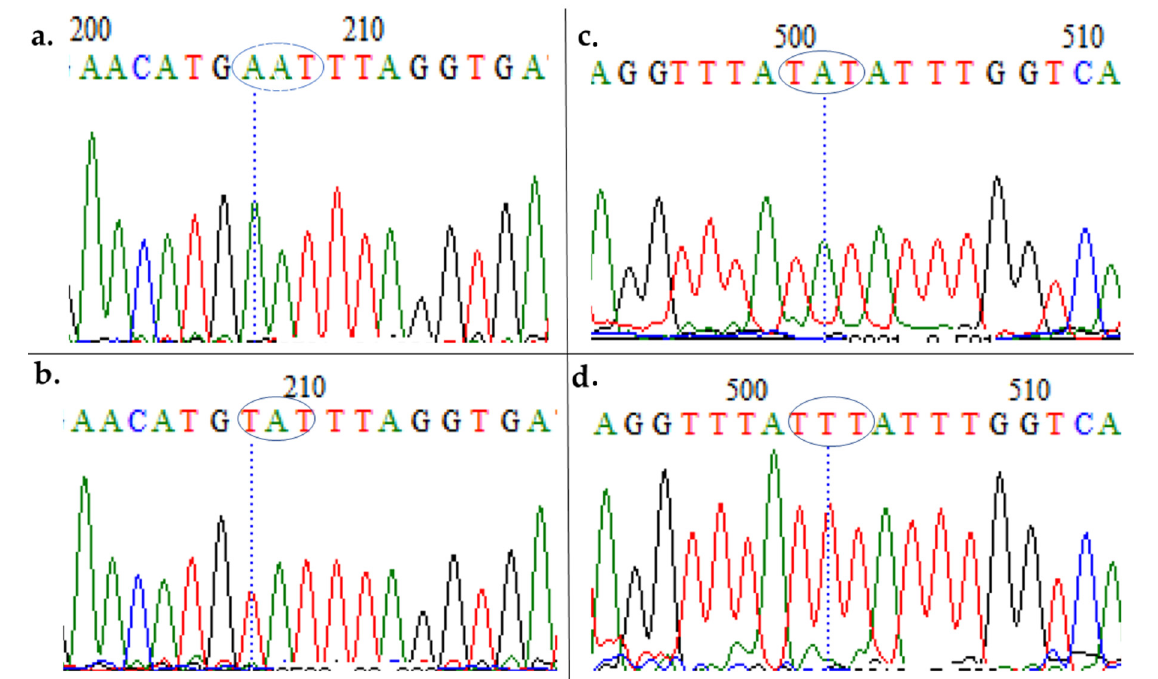
Figure 3. Analysis of the polymorphism of a fragment of the pfmdr1 gene, spanning the 86th and 184th codons. Polymorphic codons for the 86th codon: ( a ) PF3D7 and ( b ) MM106; for 184th codon: ( c ) PF3D7 and ( d )